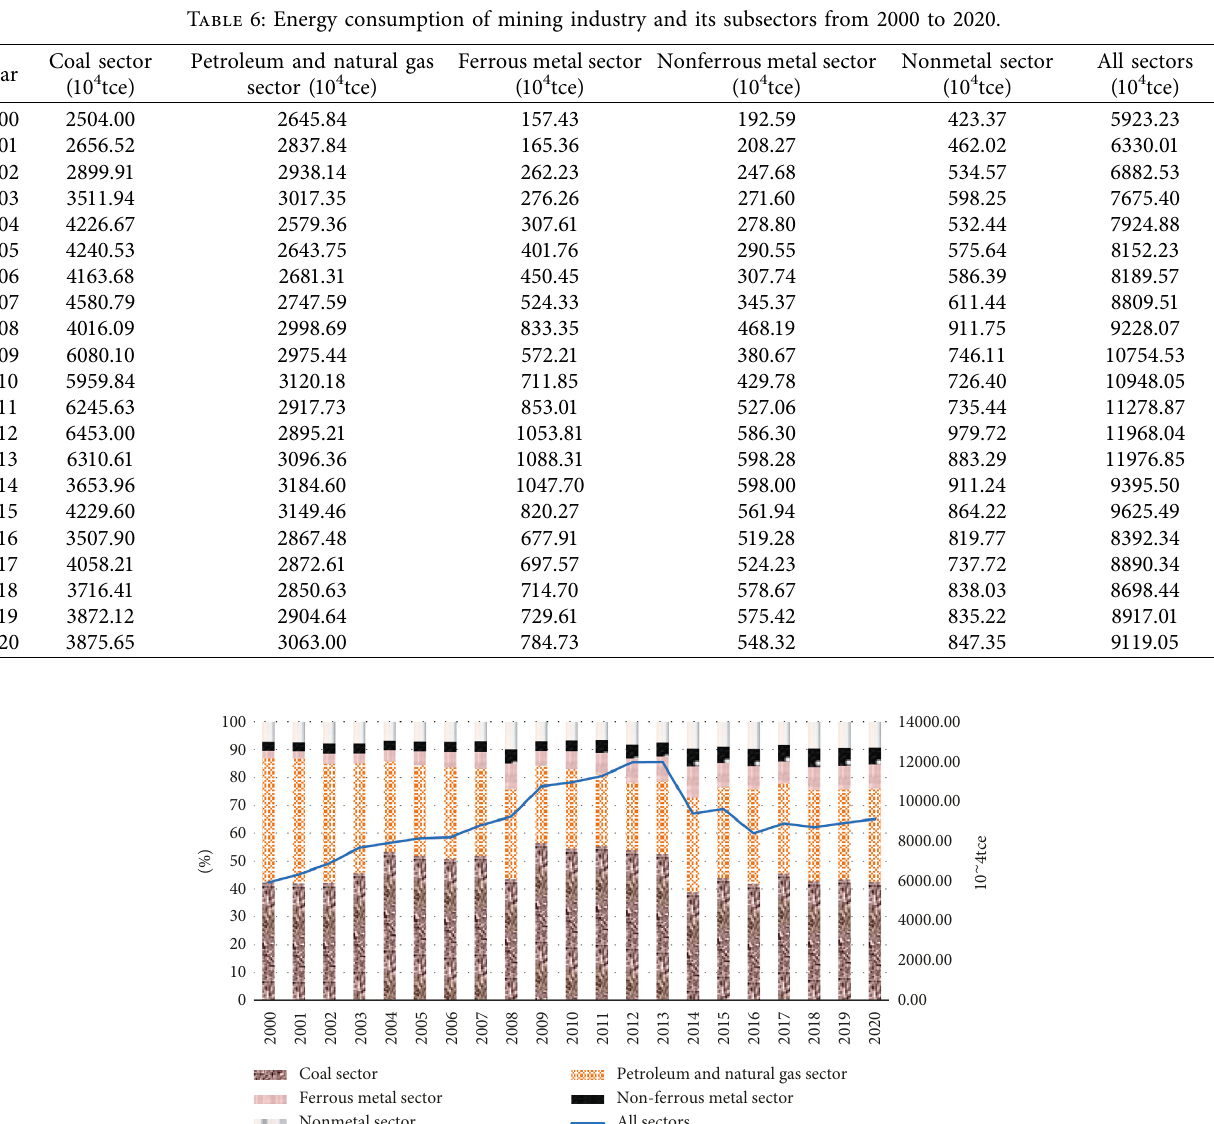
Figure 3: Comparative analysis of energy consumption of China’s mining industry and its subsectors from 2000 to 2020. Note. In Figure 3, the value of “all sectors” corresponds to the left coordinate, and other values correspond to the right coordinate.